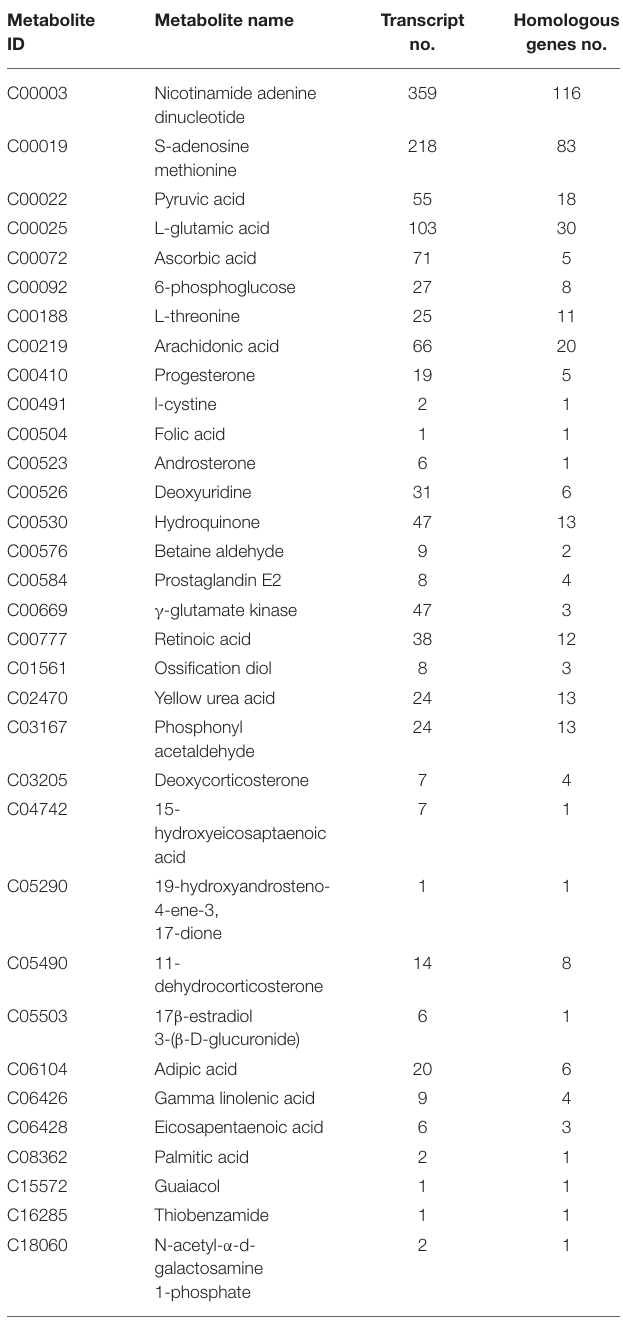
TABLE 2 | Joint analysis results of hypothalamic metabolites and transcripts in Zi-geese. Metabolite